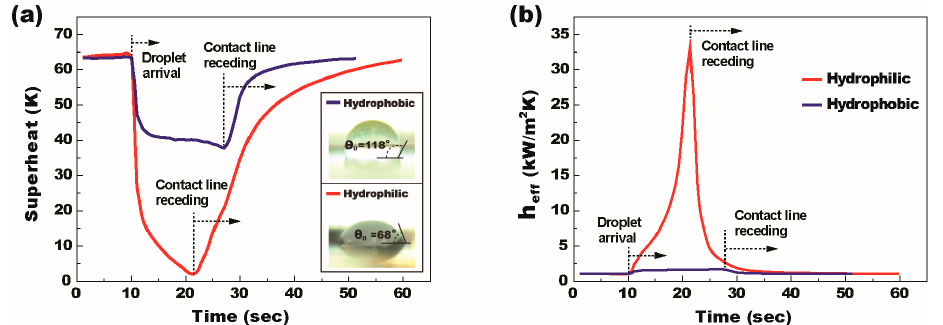
Figure 5. The SDMF’s capability for two-phase heat transfer in terms of ( a ) superheat; and ( b ) effective heat transfer as a function of time. A 5 µL water droplet was injected on a SDMF platform and